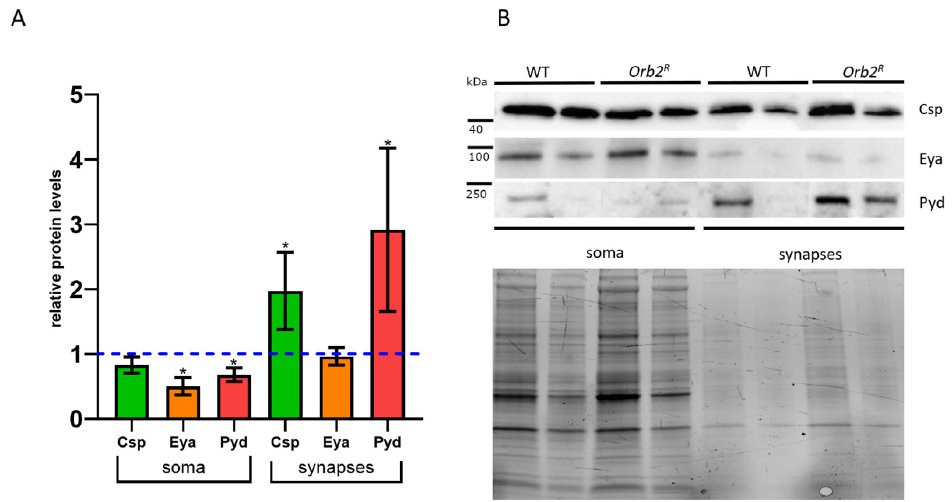
Figure 6. Intracellular distribution of proteins encoded by potential Orb2 mRNA targets. ( A ) The relative protein levels in the soma of neurons and synapses. A blue dashed line displays the protein levels in WT flies; bars show the levels in Orb2 R flies. Samples were obtained from neuron bodies (LP) and the synaptic (P2) fraction. An asterisk shows the significant change (Student t -test, n = 5, p < 0.05) in protein level in Orb2 R flies compared with WT flies. The error bar is the standard deviation. Total protein staining was used for normalization. ( B ) Western blot analysis of the fractions with antibodies against the Csp, Eya, and Pyd proteins. Two replicas of WT and Orb2 R samples are shown.